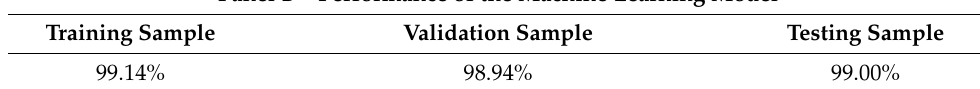
Panel B—Performance of the Machine Learning Model Training Sample Validation